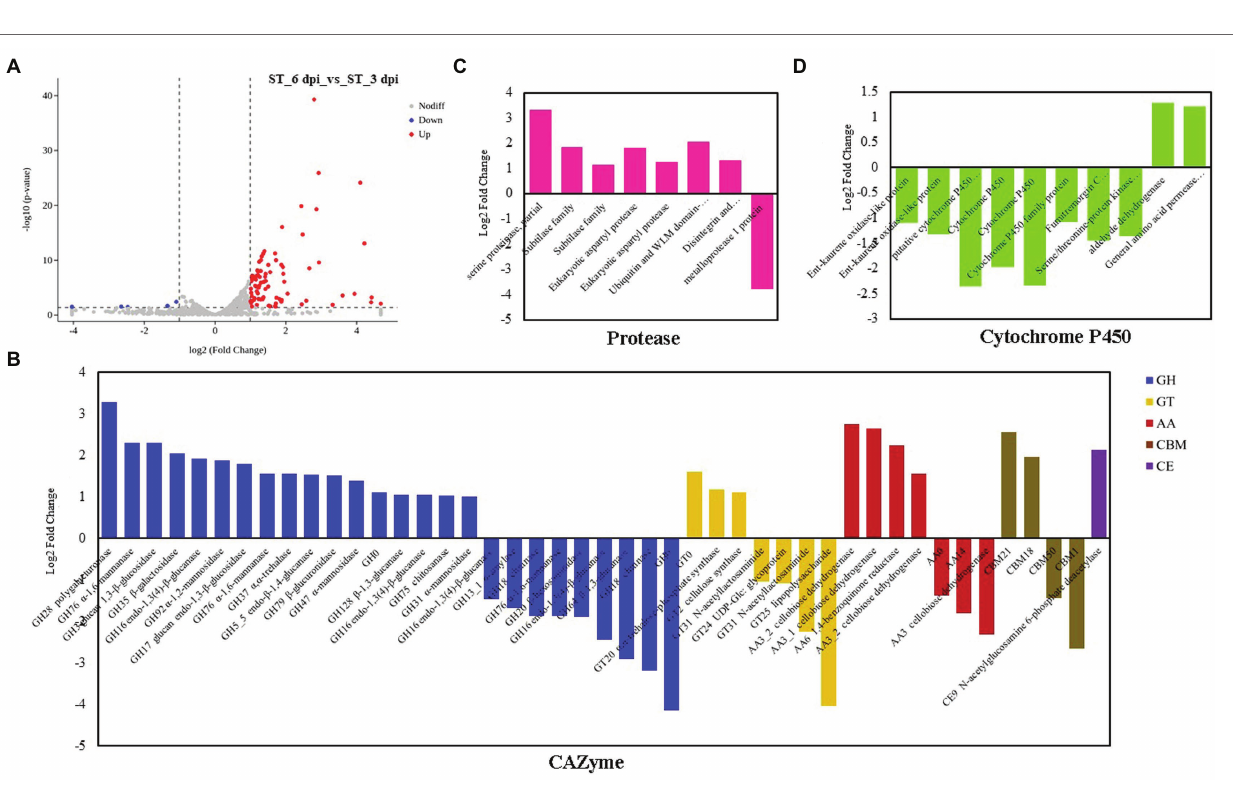
FIGURE 3 | DEGs at 6 days post-inoculation (dpi) compared with 3 dpi in Paecilomyces penicillatus . (A) Volcano plot of the DEGs in P. penicillatus . Differentially expressed CAZymes (B) , proteases (C) and cytochrome P450s (D) in P. penicillatus during the infection process. ST, inoculated samples; 3 and 6 dpi, 3 and 6 days post-inoculation; DEGs, differentially expressed